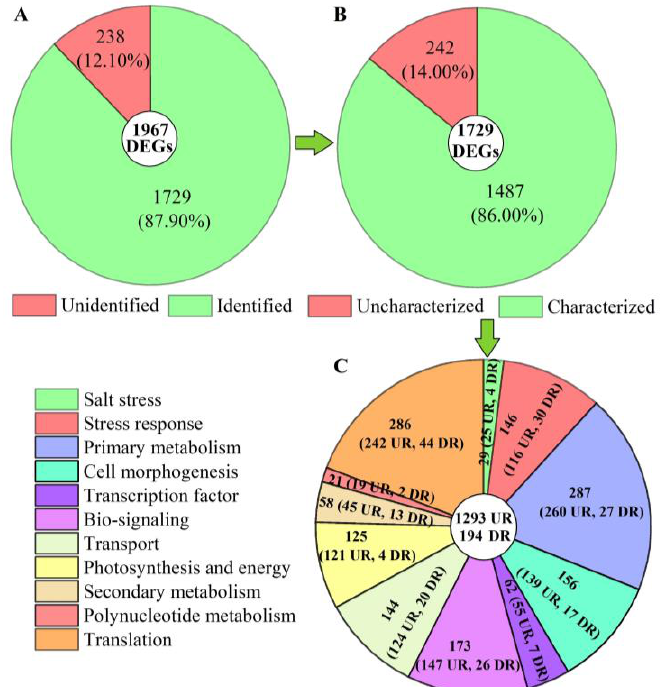
Figure 5. Distribution and classification of DEGs at 300 mmol/L NaCl vs. CK. Abbreviations: UR, up-regulated, DR, down-regulated. Image ( A ) represents the distribution of unidentified and identified genes; image ( B ) represents the distribution of uncharacterized and characterized genes, and image ( C ) represents the classification of the characterized biological functional genes.